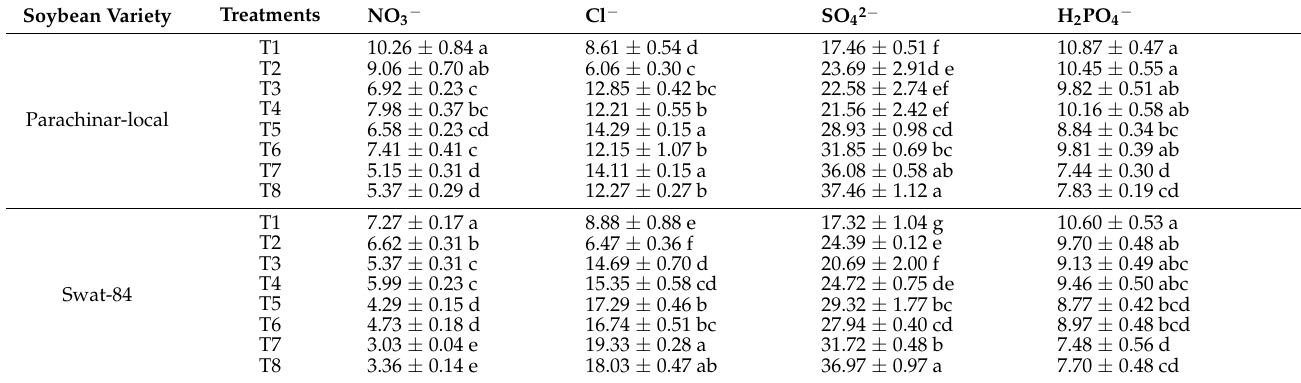
Table 3. Changes in foliar anions concentration of both soybeans.